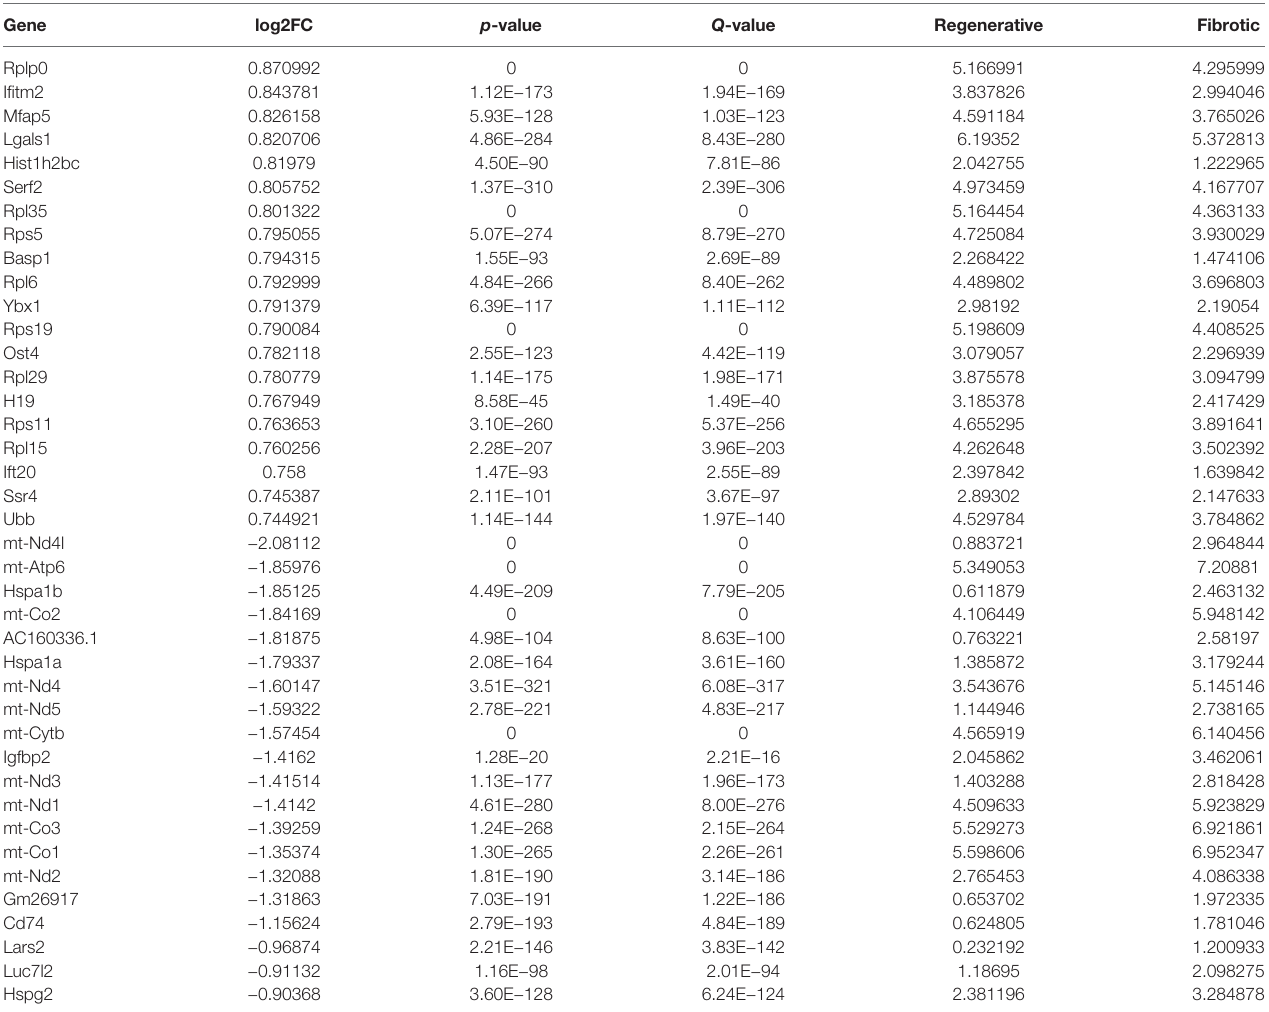
TABLE 2 | The fi rst 20 up- and downregulated speci fi c genes between fi brotic and regenerative myo fi broblasts. Gene log2FC p -value Q -value Regenerative Fibrotic